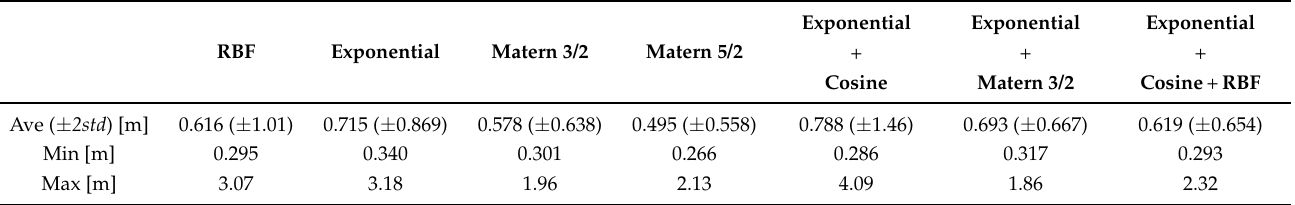
Table 4. Results of localization experiments. The results of this experiment summarize the calculation of the mean and standard deviation as well as the minimum and maximum values from 100 localization